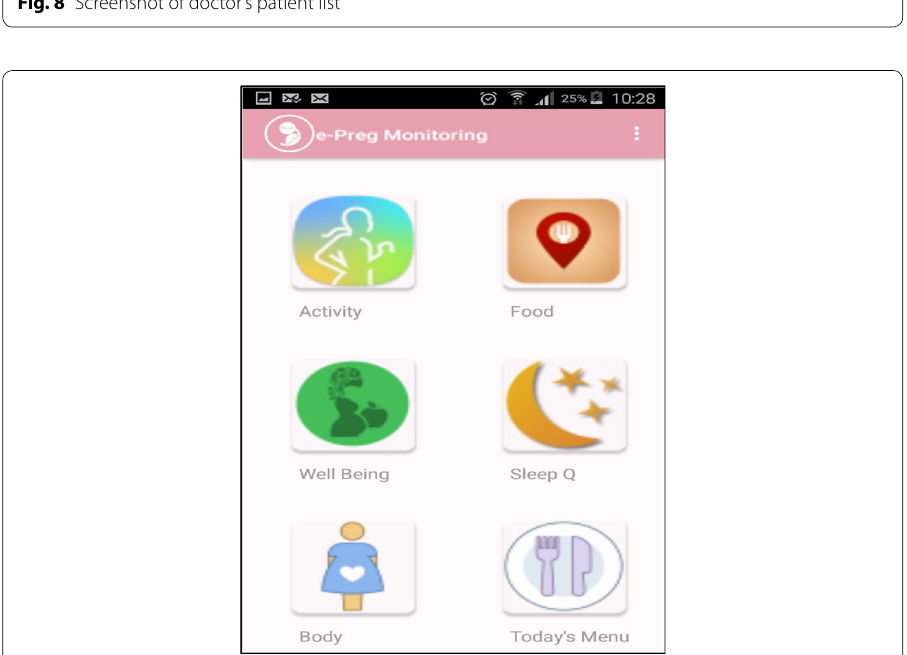
Fig. 9 Screenshot of patient’s